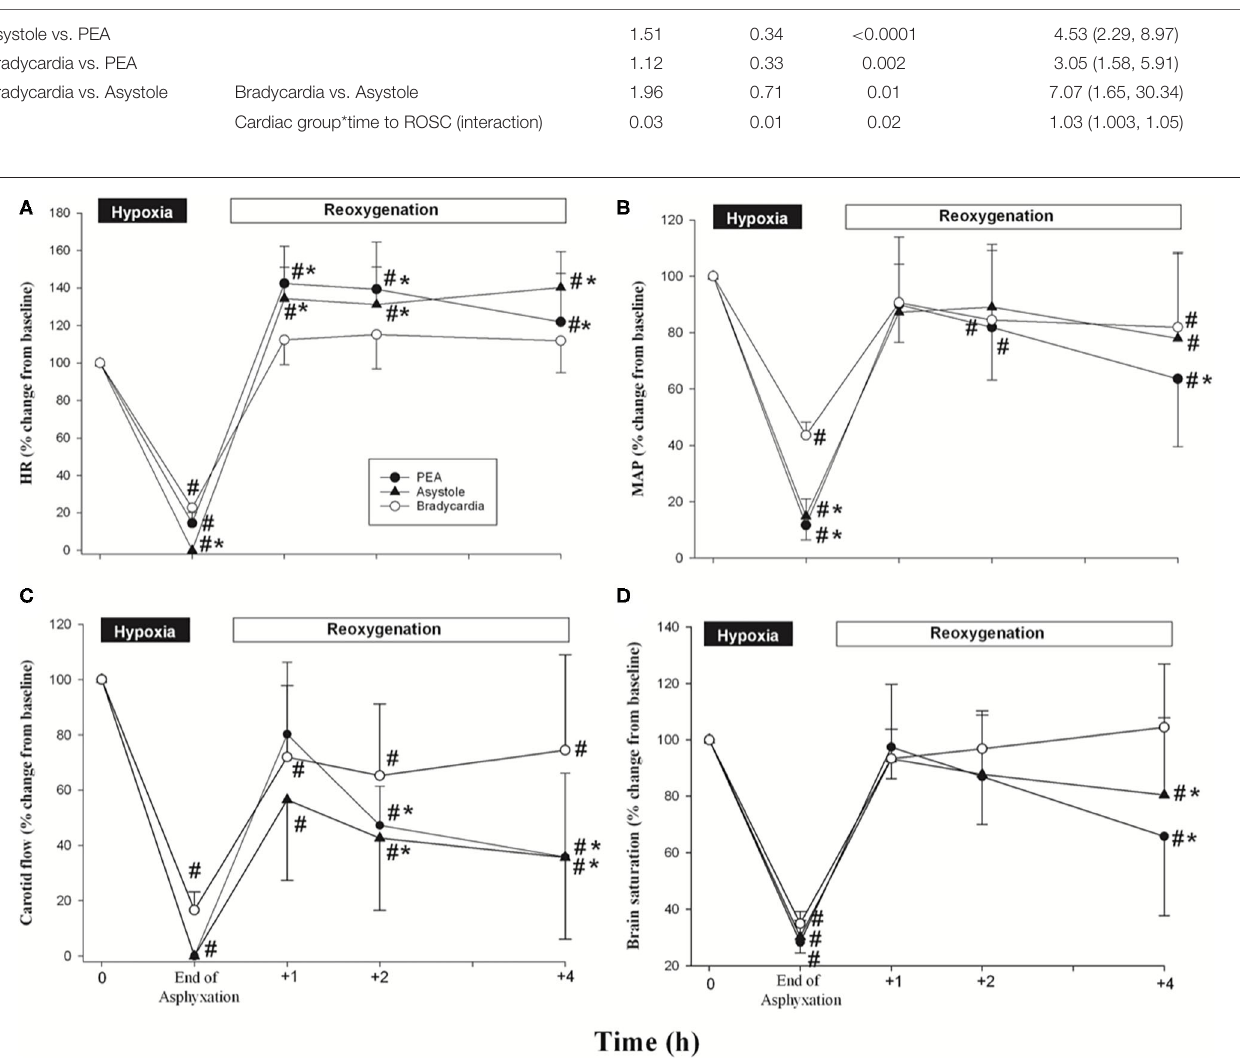
FIGURE 2 | Percentage changes from normoxic baseline in (A) heart rate, (B) mean arterial pressure (MAP), (C) carotid blood flow, and (D) brain saturation in bradycardia ( ◦ ), PEA (•), and asystole ( N ) groups during hypoxia/asphyxia and after resuscitation. Each point represents mean ± SD. * p < 0.05, significantly different from bradycardia group; # p < 0.05, significantly different from its own baseline